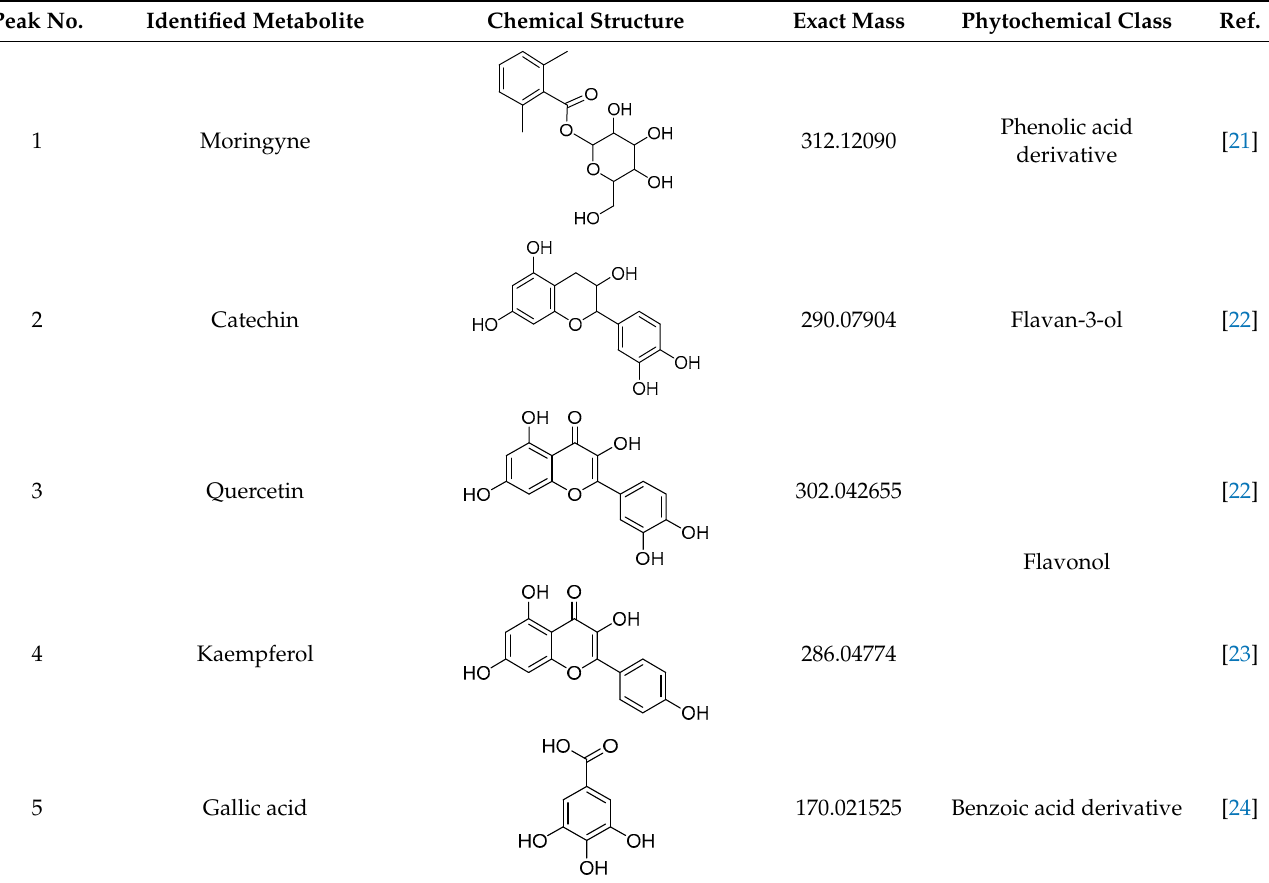
Table 1. Tentative identification of key metabolites in Moringa oleifera seeds extract. Identification of the compounds was based on HR-ESIMS and comparison with the data reported in the literature. Peak No.